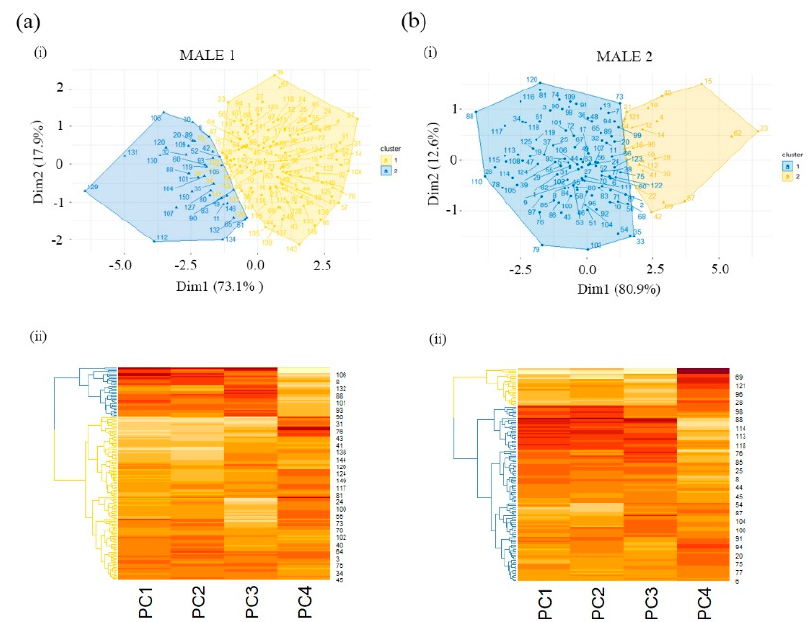
Figure 3. Bottlenose dolphin ( Tursiops truncatus ) sperm clustering. ( i ) Graphs showing two cluster areas (blue for cluster 1 and yellow for cluster 2) of sperm populations in both males of the study ( a , b ). The numbers indicate individual sperm classified in the clusters. ( ii ) Hierarchical tree/dendrogram combined with heatmap. The dendrograms indicate the relationships between the principal com- ponents (columns) and spermatozoa (rows) based on Spearman’s correlation coefficients. Each leaf corresponds to one spermatozoon. As we move up the tree, spermatozoa that are similar to each other are combined into branches, which are themselves fused at a higher height. Horizontal axis shows the height of the fusion that indicates the dissimilarity or similarity distance between two spermatozoa. Similarity decreases with the height of fusion. Heatmaps show the columns/rows of the data matrix reordered according to the hierarchical clustering result, placing similar spermatozoa close to each other based on principal components (PC1, PC2, PC3 and PC4). Spermatozoa similarity or dissimilarity is indicated by an orange scale. Dark orange indicates high similarity; light orange indicates low similarity.